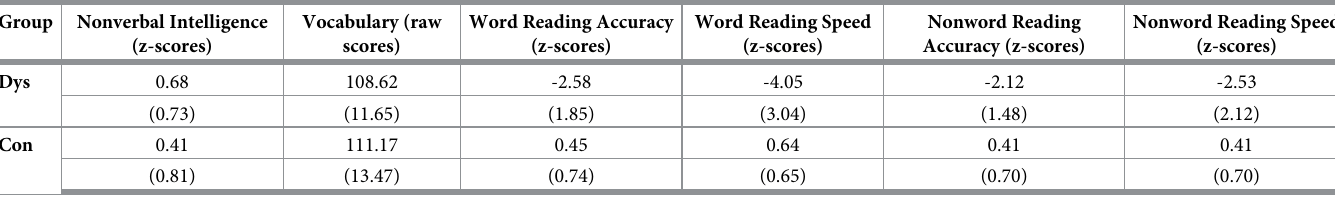
Table 3. Means (and SDs) of the two groups in nonverbal intelligence (CPM Raven), vocabulary (PPVT-R), and word and nonword reading (DDE-2). Group Nonverbal Intelligence